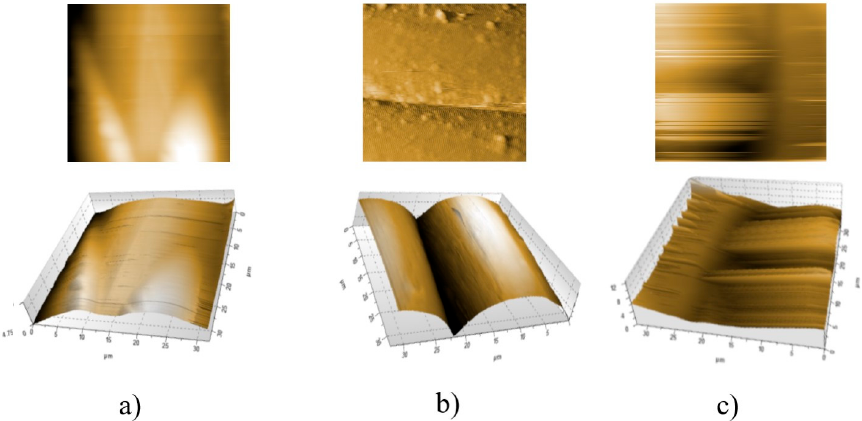
Figure 2. 2D and 3D AFM images: ( a ) polyamide; ( b ) P-E-PANI-PSSA (polyamide); ( c ) W-E-PANI- PSSA (wool).